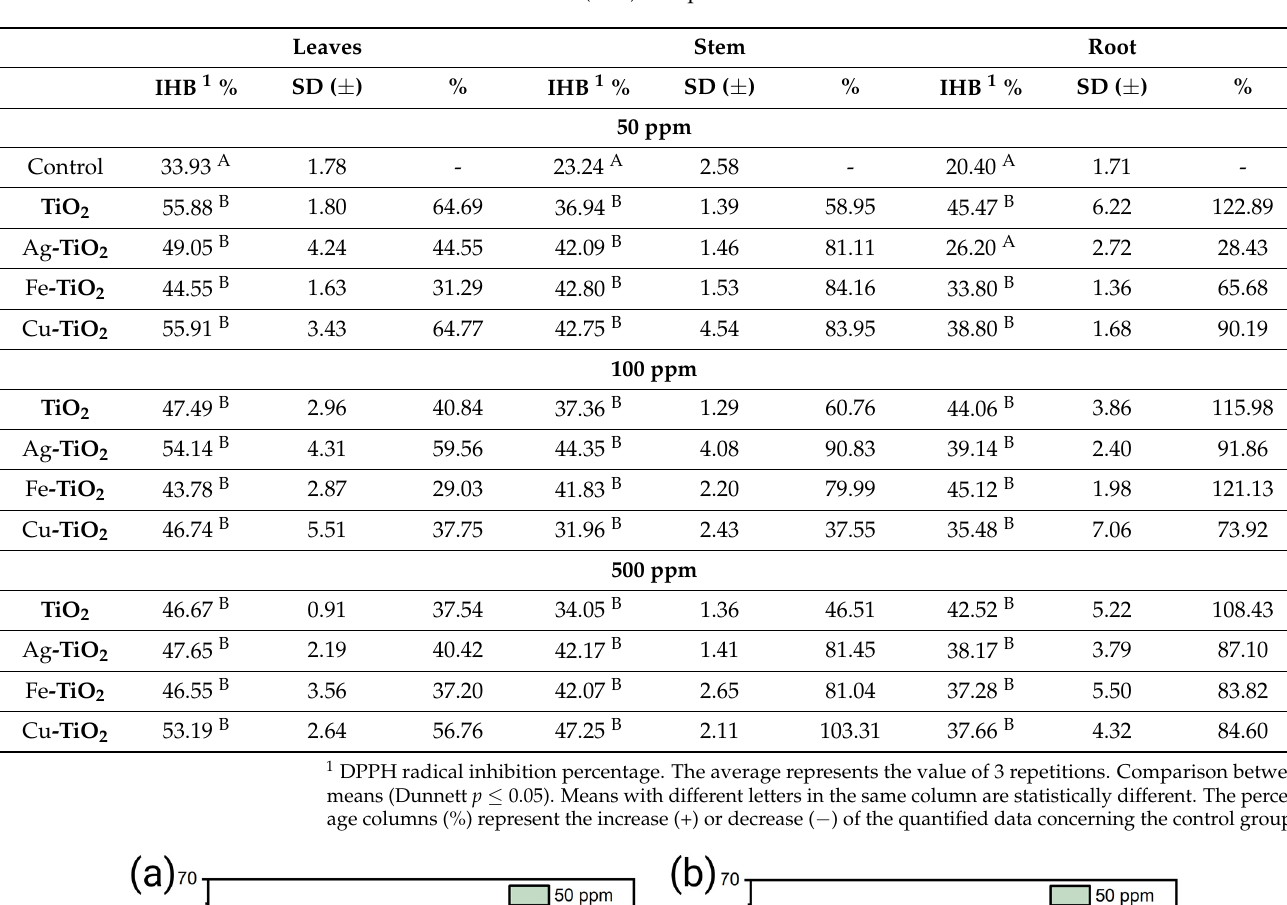
Table 5. DPPH inhibition (IHB)% in plants treated with SG-Mw NMs. Leaves